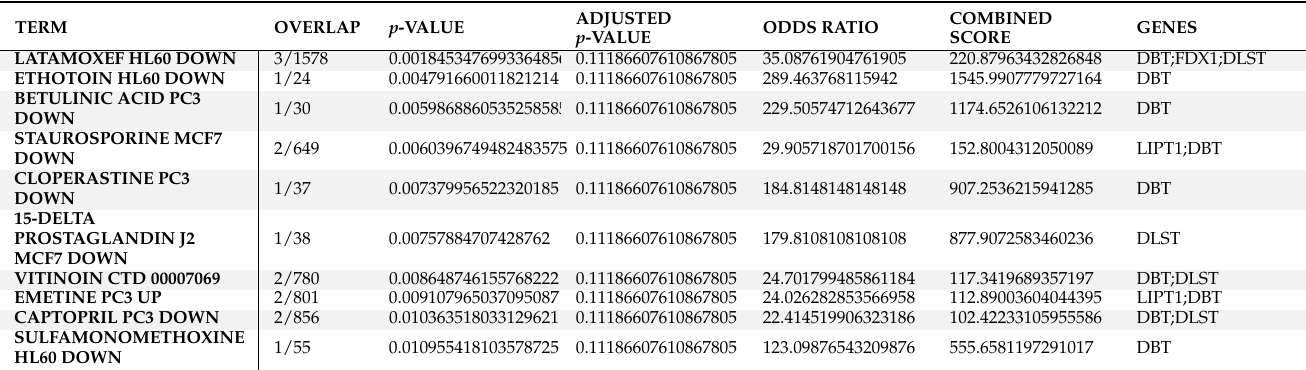
Table 1. Suggested top 10 small molecules for OA. OA, osteoarthritis.